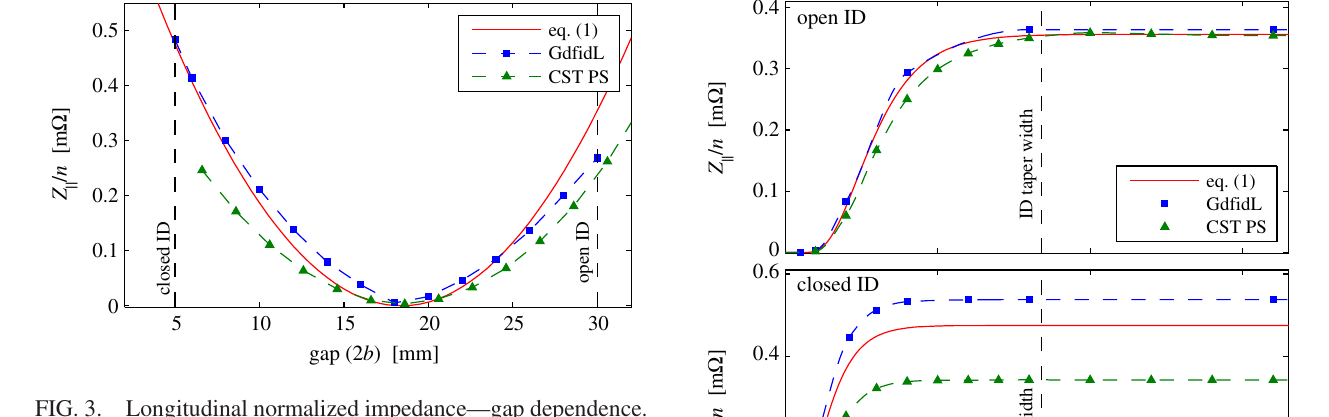
FIG. 3. Longitudinal normalized impedance — gap dependence.